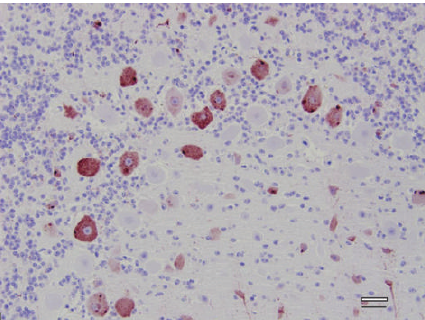
Figure 1: Photomicrograph of immunohistochemical stain of cere- bellar cortex from the second bison to die from rabies. Many Purkinje cells (large cells) and small nerve cells contain moderate to marked brown staining of rabies antigen in cytoplasm. IHC, antirabies globulin, and Harris hematoxylin counterstain. 200x.